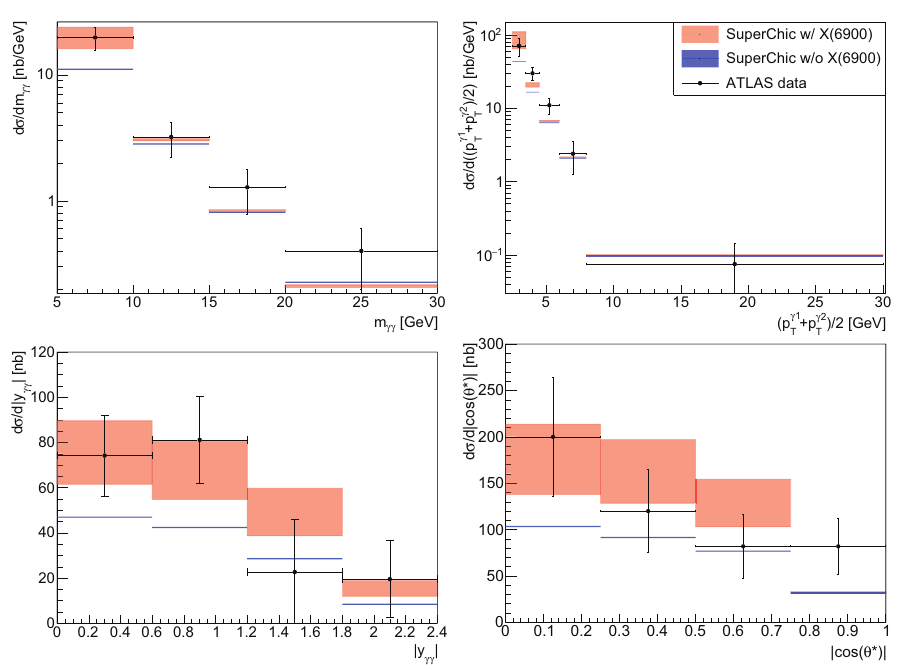
Figure 2. Differential fiducial cross sections of γγ → γγ production in Pb + Pb collisions at a centre- √ s NN = 5 . 02 TeV with integrated luminositiy 2.2 nb − 1 for four observables (from of-mass energy of left to right and top to bottom): diphoton invariant mass m γγ , diphoton absolute rapidity | y γγ | , average + p γ 2 / 2) | . The red band ) / 2 and diphoton | cos ( θ ∗ ) | ≡ | tanh( Δ y γ photon transverse momentum ( p γ 1 T T 1 ,γ 2 represents an uncertainty (1 σ range) of the fit with X (6900). The blue band contains only the statistical uncertainty of the SuperChic simulation without X -resonance.